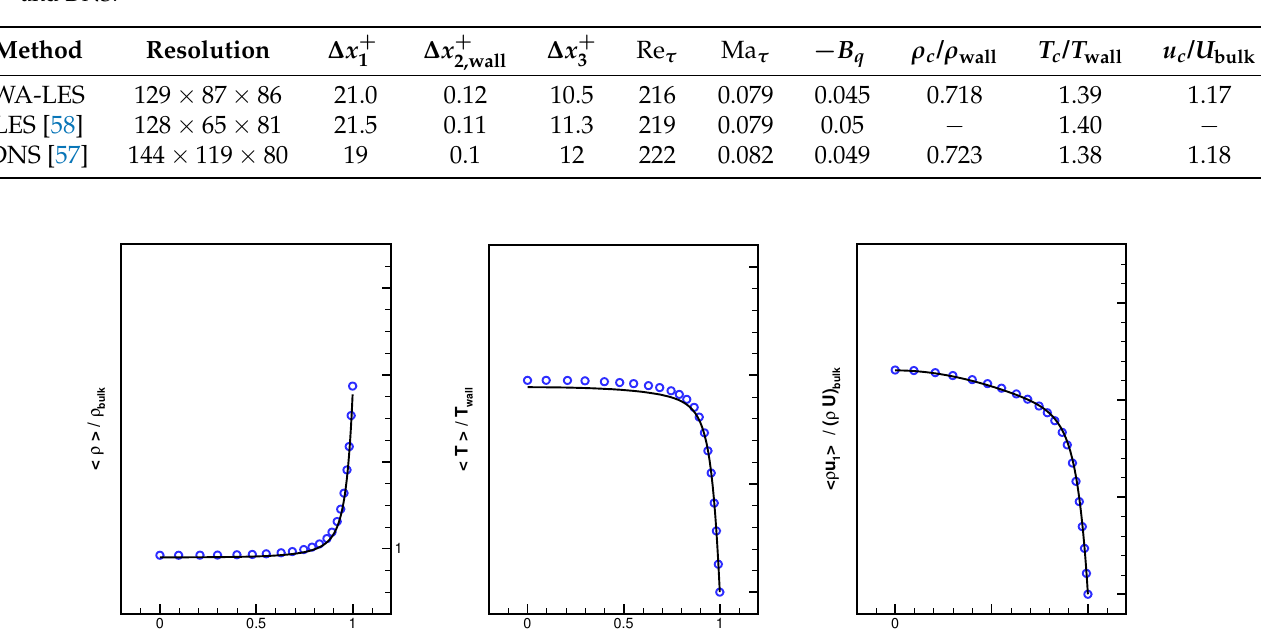
Table 1. WA-LES of supersonic channel flow: mesh resolution and mean flow results compared to conventional LES and DNS.